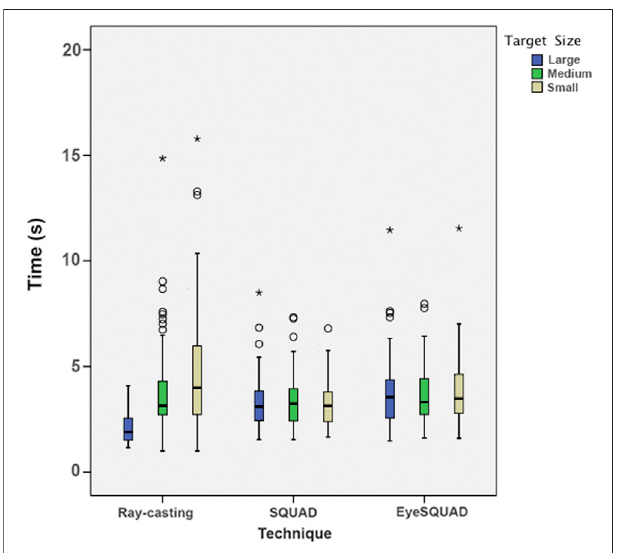
FIGURE 8 | Interaction between technique and target size on